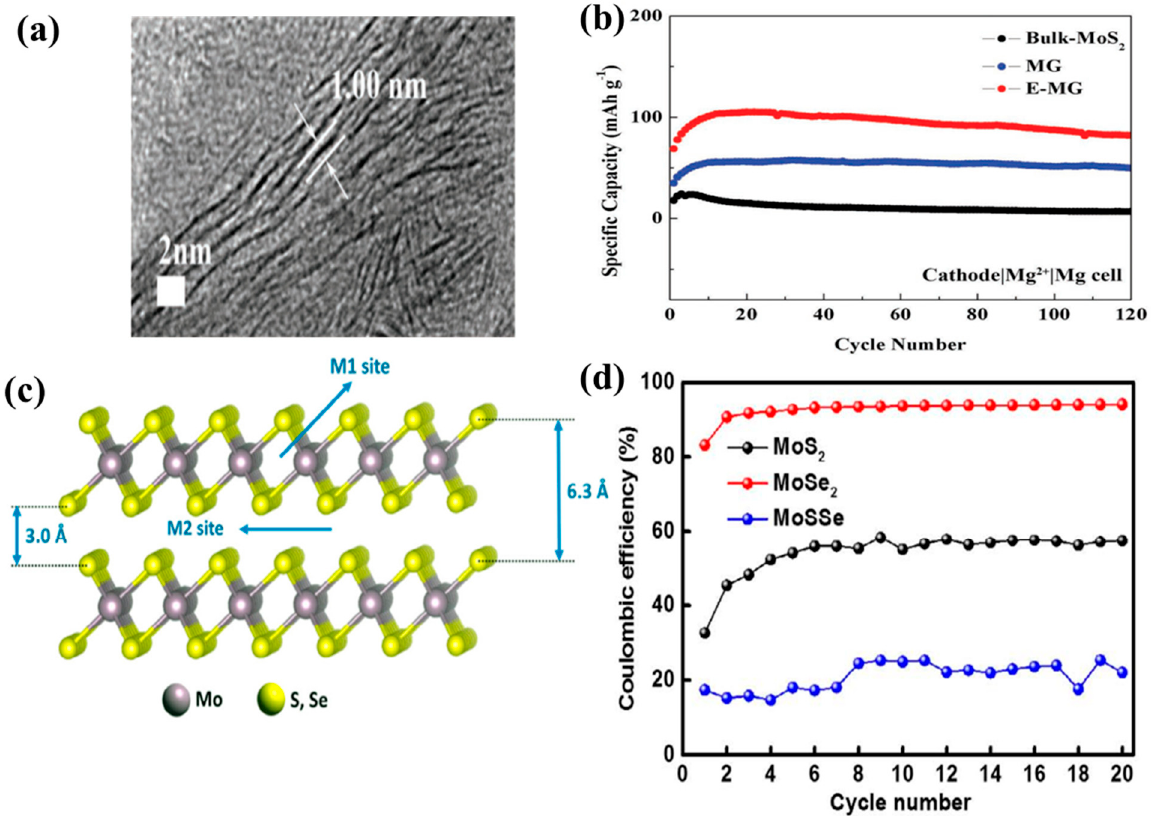
Figure 9. ( a ) TEM image of freestanding MoS 2 -graphene foam composite with glucose (E-MG), ( b ) cyclic performance of bulk-MoS 2 , MoS 2 -graphene foam without glucose (MG), and E-MG at 20 mA g − 1 . Reprinted with permission from Fan et al. [104] Copyright 2017, WILEY-VCH Verlag GmbH and Co. KGaA, Weinheim. ( c ) Schematic of the MoX 2 structure (X: S, Se) with M1 and M2 site, ( d ) coulombic efficiency of MoX 2 at 100 mA g − 1 . Reprinted with permission from Divya et al.